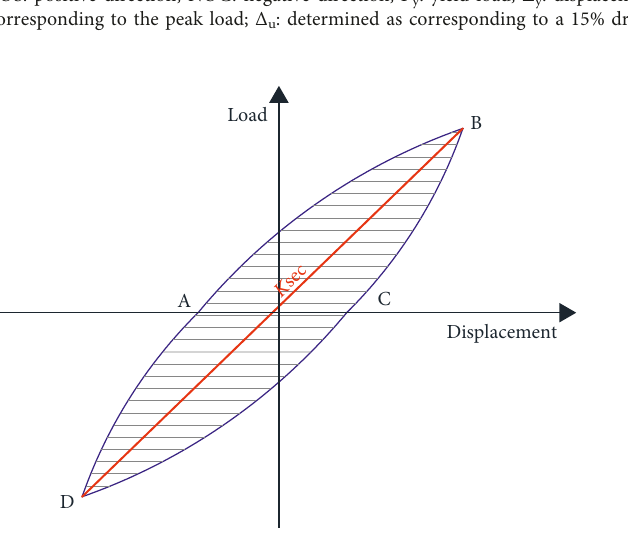
Figure 12: Representation of energy dissipated and secant stiffness.